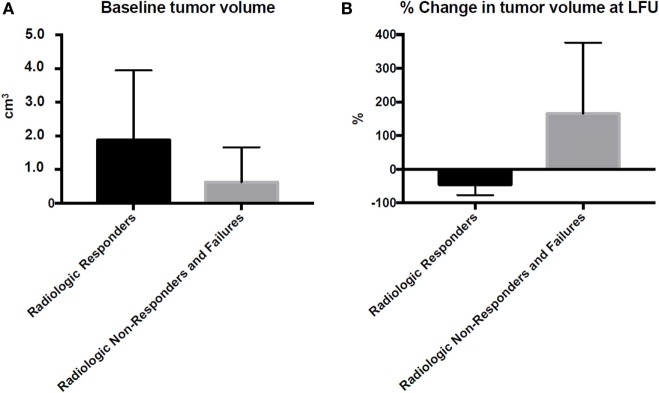
Tumor volume at baseline and change in tumor volume at last follow-up. Tumor volumetric data were gathered from MRI prior to treatment (A) and after treatment (B) at the last clinic visit. Percentage change in tumor volume at last follow-up is relative to the baseline tumor volume. LFU, last follow-up.